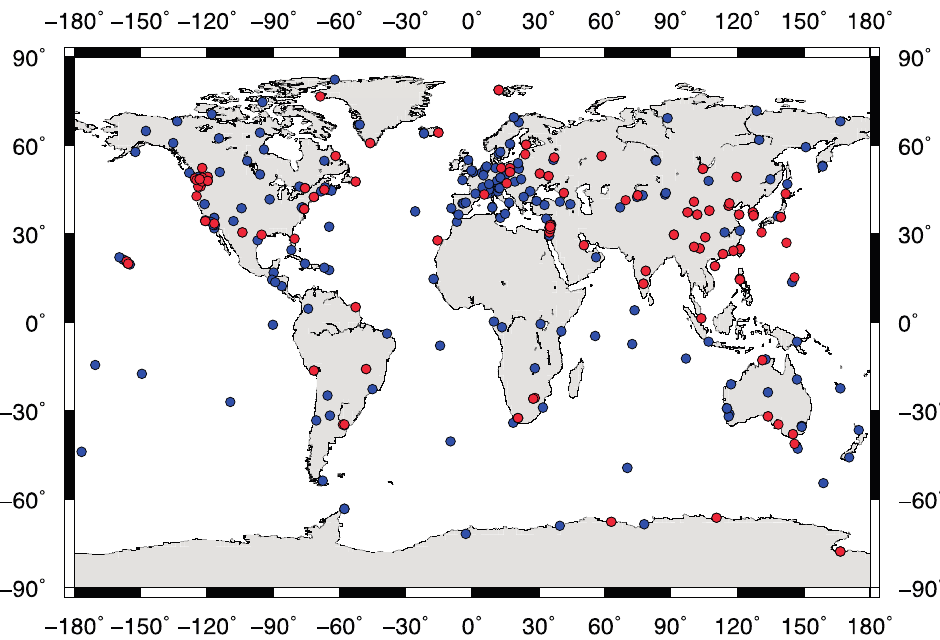
Figure 3. 269 GPS stations over the globe are tested from the IGS and regional networks. The red doted 89 sites have both the seasonal and quasi-biennial signals, and the blue doted sites have only the seasonal